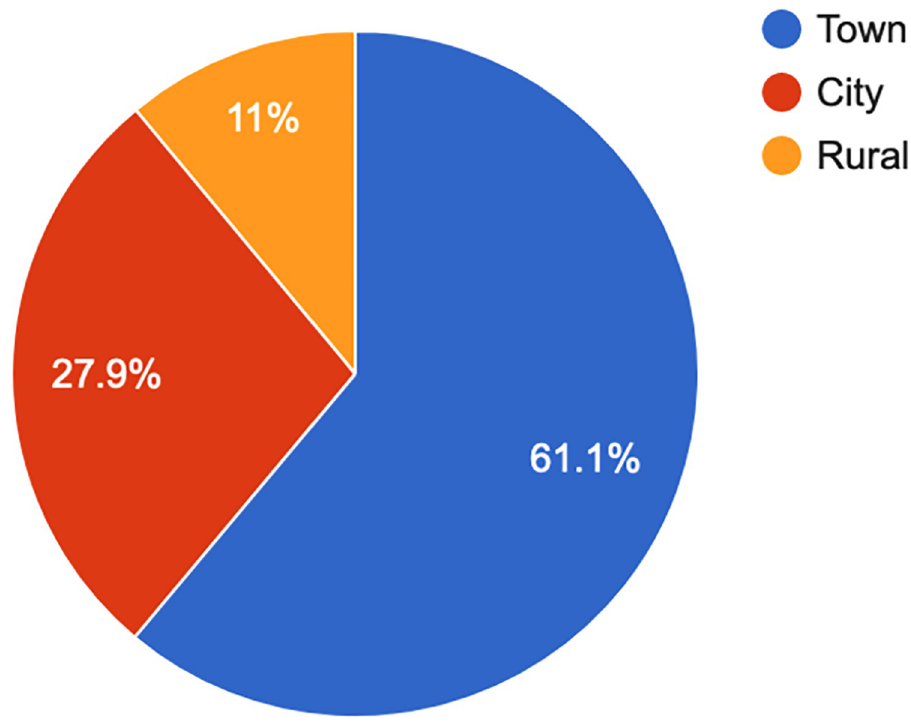
Fig 1. Geography.